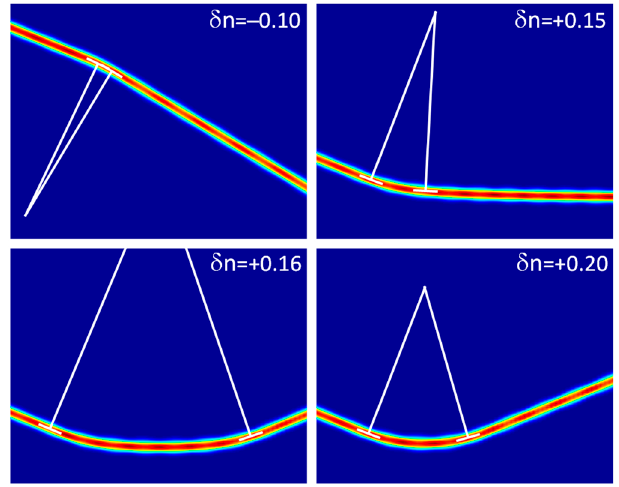
Figure 7. Determination of the radius of curvature of the osculating circles for different trajectories of the solitonic waveguides.